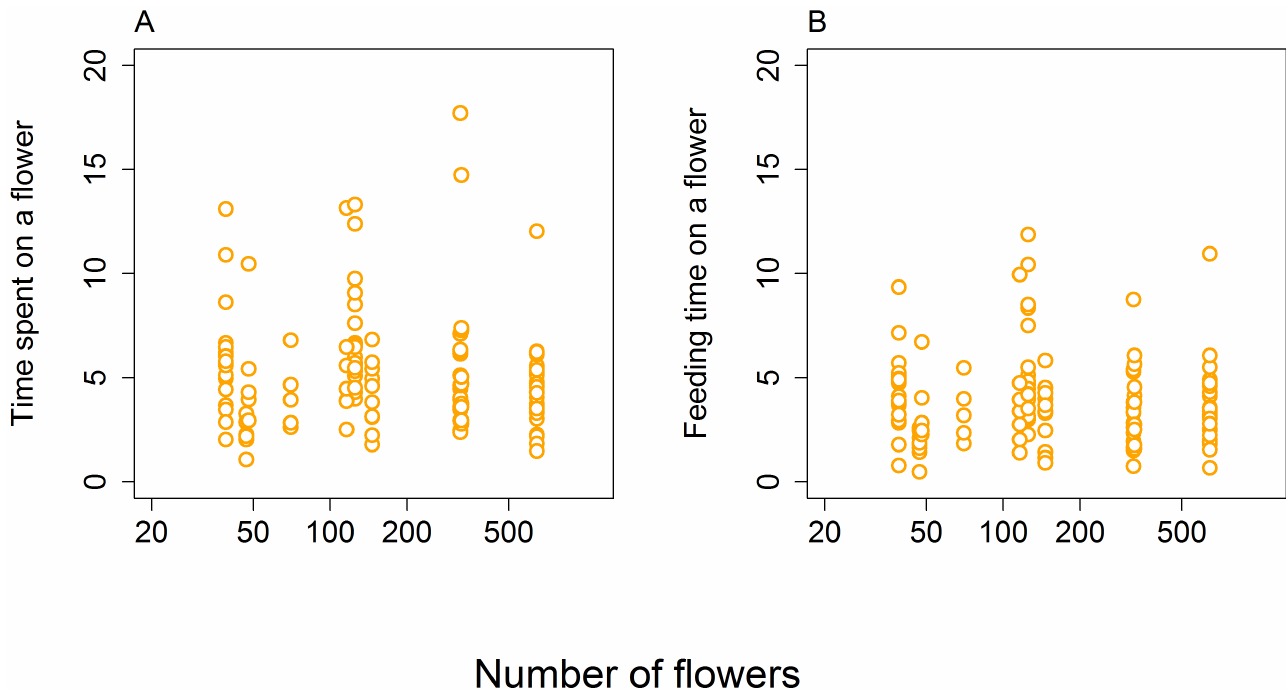
Fig 3. Honeybees’ handling time per flower was independent of the number of flowers in clusters of different sizes. A: Total time spent on a flower measured from video recordingsas the time from the first contact until take-off. B: Feedingtime estimated as the time honeybees spent with their head deep insidethe flower. Both are measuresof handlingtime excludingmovement